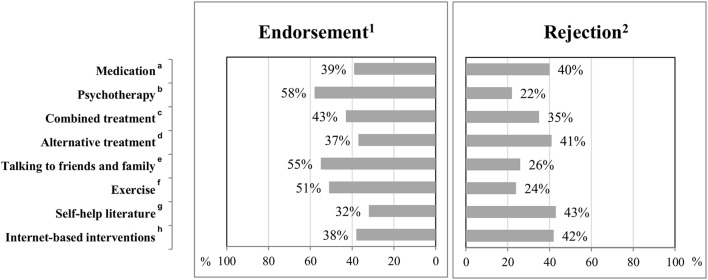
Treatment preferences for depression in primary care. 1Endorsement: likely or very likely; 2Rejection: unlikely or very unlikely; an = 637; bn = 633; cCombined treatment refers to medication and psychotherapy, n = 615; dAlternative treatment (e.g. alternative practitioners), n = 623; en = 634; fn = 638; gn = 629; hn = 631; percentage of respondents “undecided”: an = 132 (21%); bn = 125 (20%); cn = 135 (22%); dn = 141 (23%); en = 122 (19%); fn = 159 (25%); gn = 154 (24%); hn = 127 (20%).